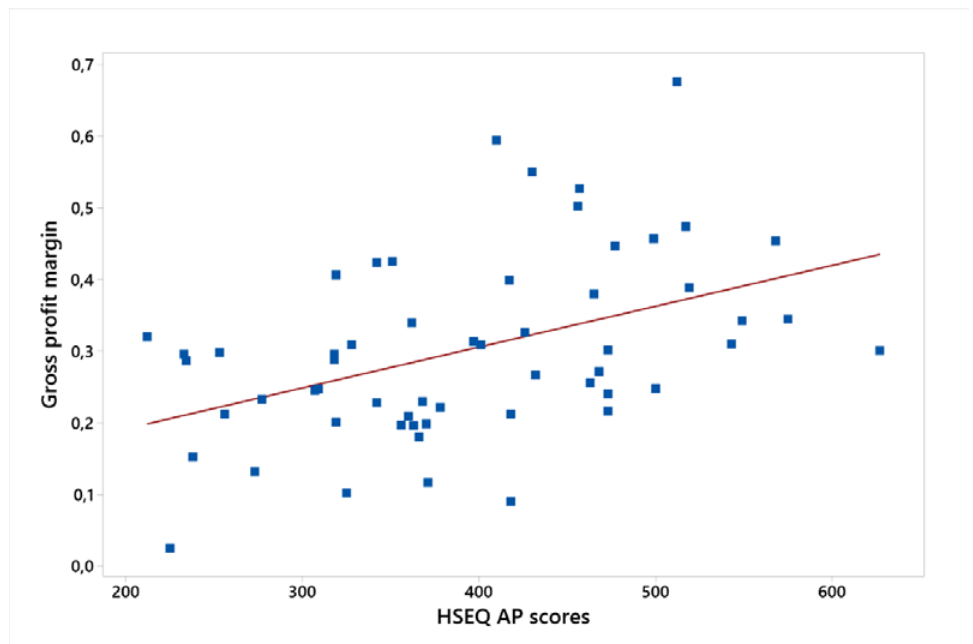
Figure 4. HSEQ AP scores vs. gross profit